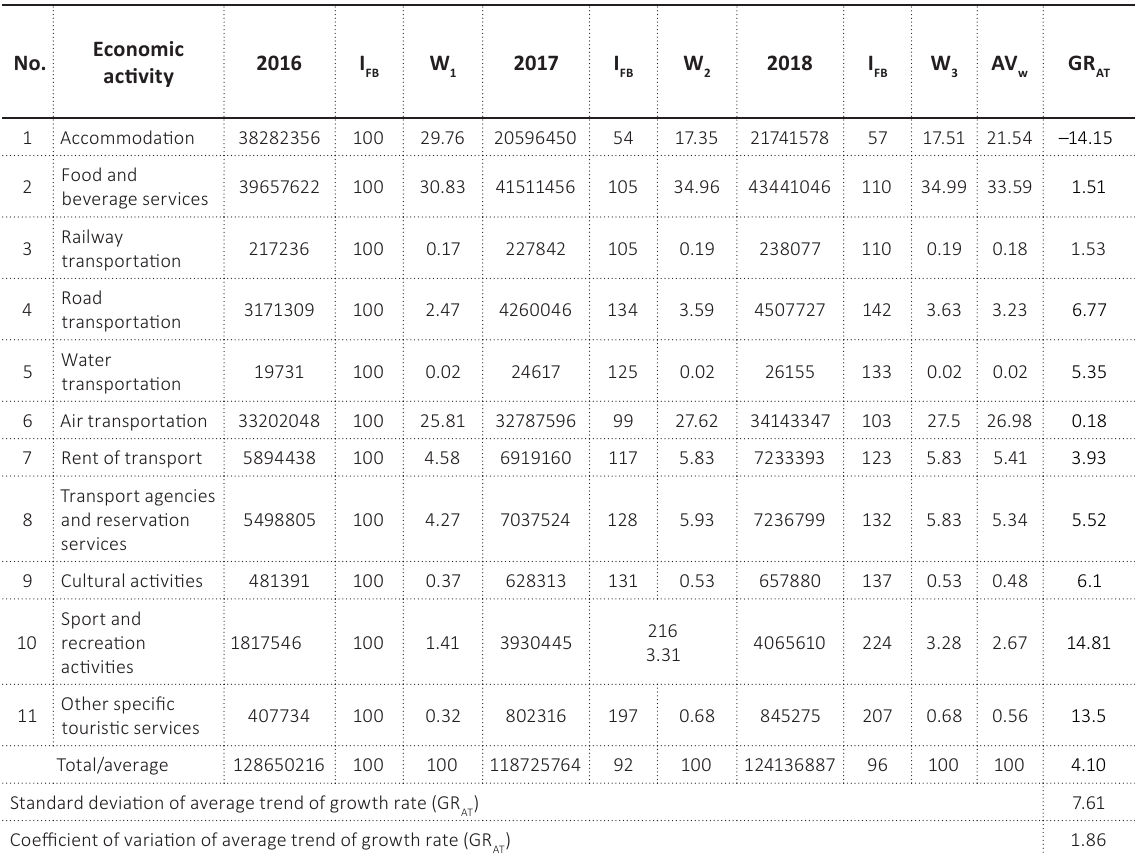
Source: General Authority for Statistics